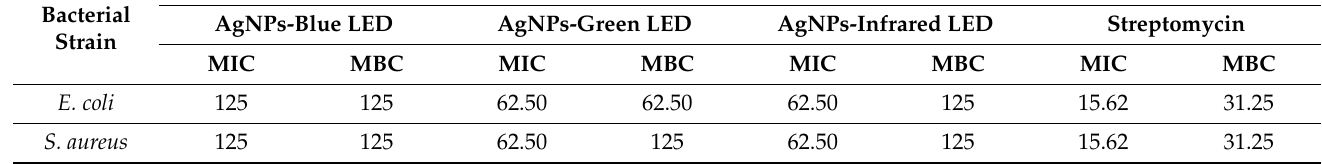
Table 4. Antimicrobial activity of LED-biosynthesized AgNPs against S. aureus and E. coli K 12 evalu- ated by the minimum inhibitory concentration: MIC and the minimum bactericidal concentration: MBC ( µ